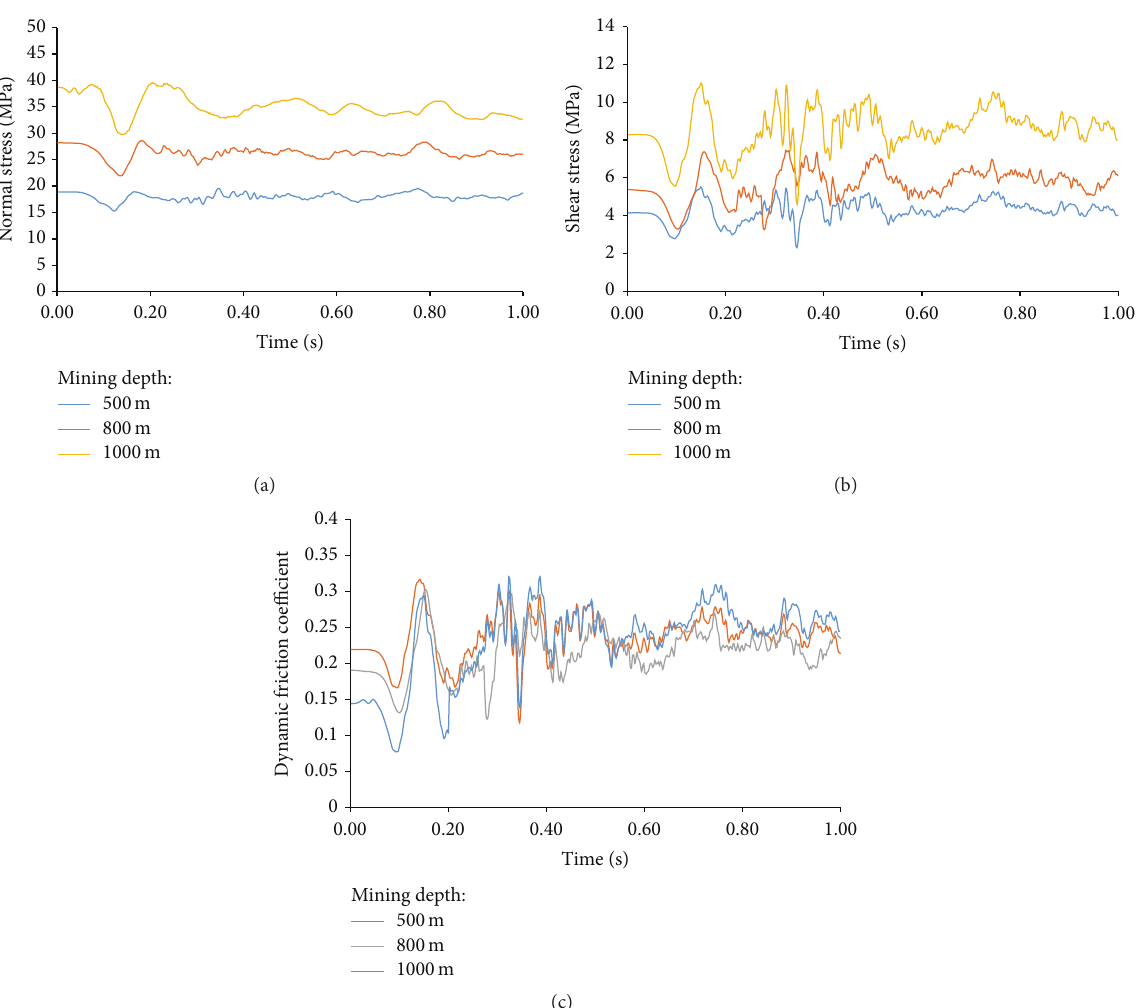
Figure 5: Stress evolution under dynamic disturbance in different depths ( 𝑝 𝑑𝑚 = 30 MPa, depth = 500 m): (a) normal stress; (b) shear stress; and (c) dynamic friction coefficient.